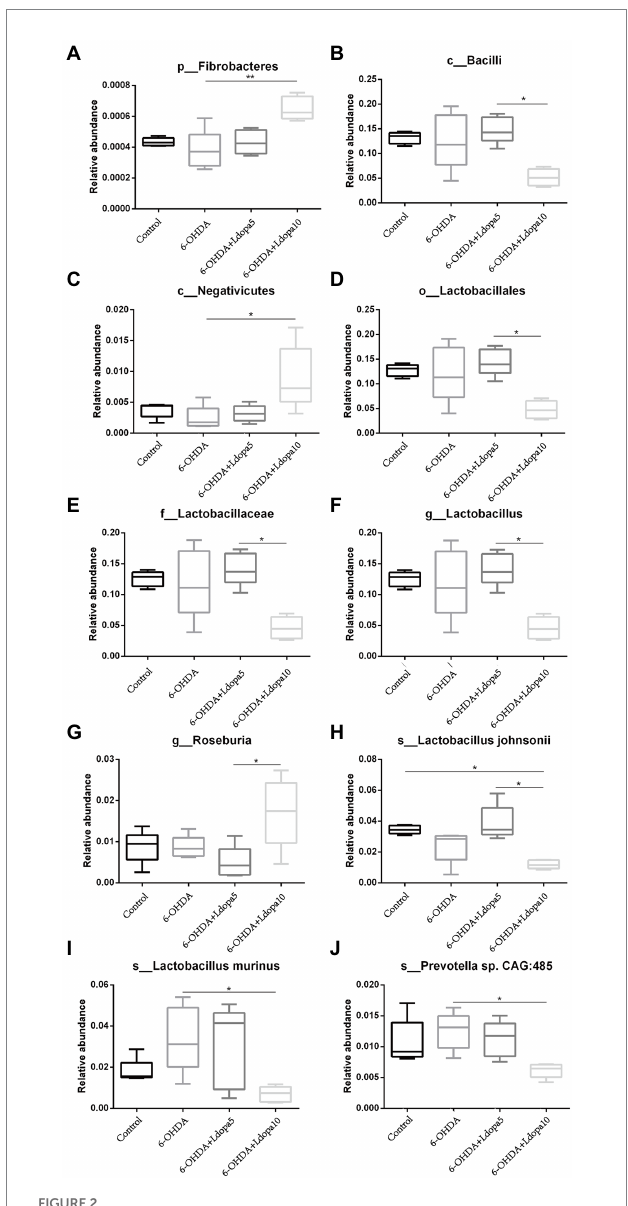
FIGURE 2 Differences of bacterial taxa of the 10 most abundant taxa were shown. The relative abundance of differentially abundant bacteria taxa in gut microbiota among control, 6-OHDA and levodopa-treated 6-OHDA groups at phylum level (A) , class level (B,C) , order level (D) , family level (E) , genus level (F,G) and species level (H–J) was detected. The horizontal axis is sample grouping, the vertical axis is the relative abundance of the corresponding taxa, the horizontal line represents the two groups with a significant difference, and none means there is no difference between the two groups. The asterisks indicated statistical significance tested using one-way ANOVA followed by Dunnett’s test (* p < 0.05, ** p <